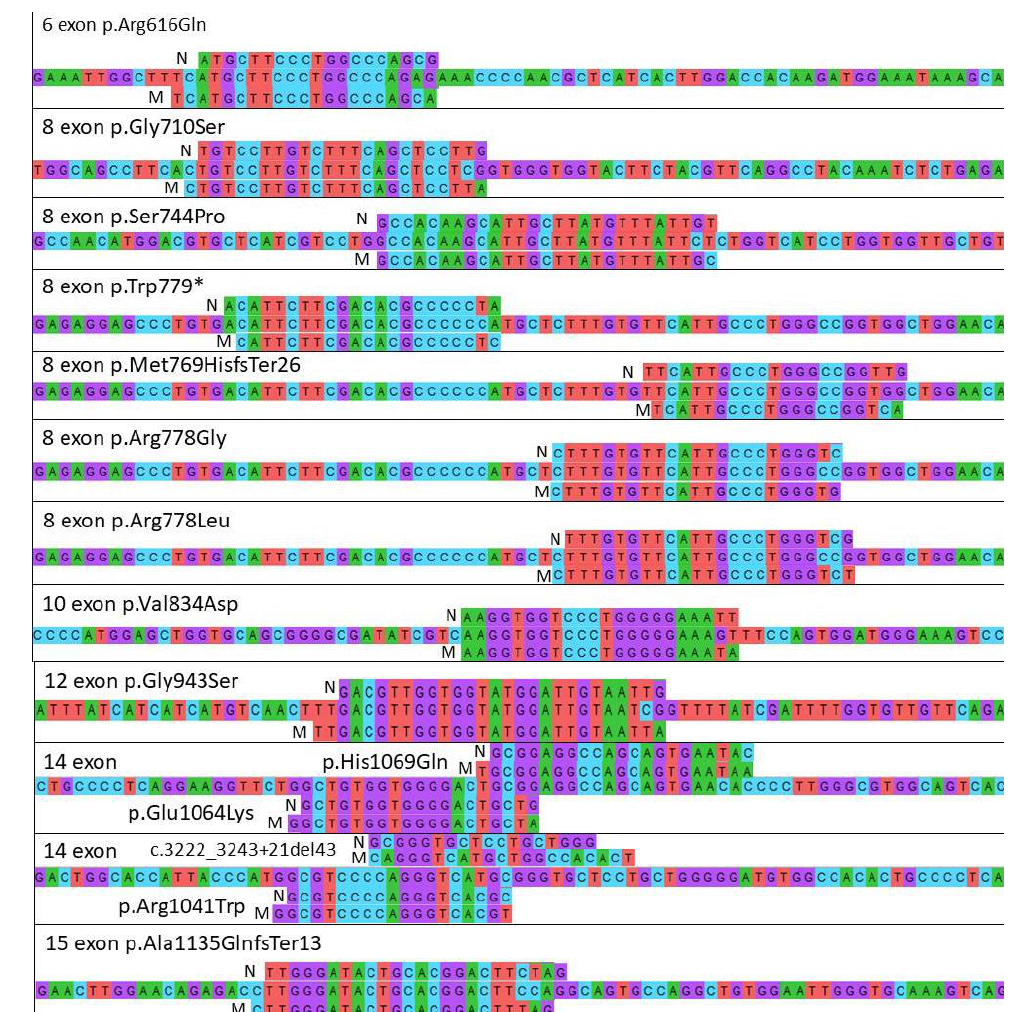
Figure 1. Schematic representation of the exons of the ATP7B gene and the location of the detected mutations.